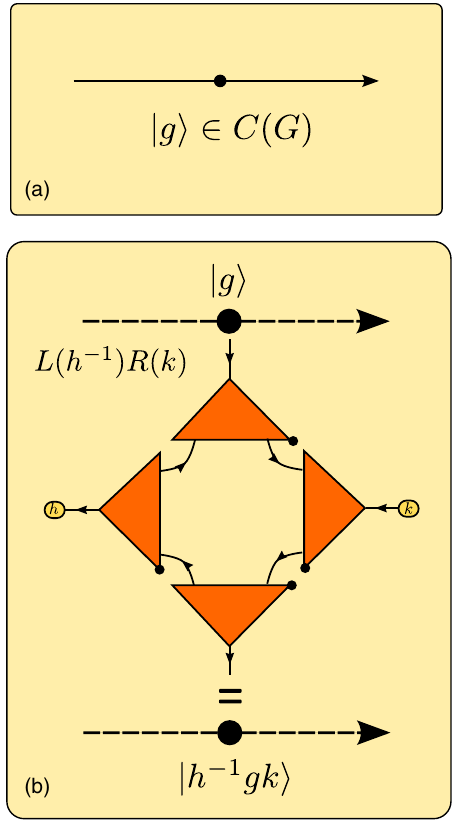
FIG. 6. Gauge boson constituents are defined on the links of an oriented lattice. Links are represented by dashed lines, and constituents are small solid circles along these lines (which should not be confused with tensors, whose legs are solids lines). (a) In the Kogut-Susskind LGT, each constituent is described by a state j g i of the group algebra C ð G Þ . (b) Left and right rotations L ð h − 1 Þ and R ð k Þ are introduced in Eqs. (11) and (12). They transform the state j g i into j h − 1 gk i . Both operators require an ⊗ ¯ V V initial change of basis from C ð G Þ to ⊕ , obtained r ð r r Þ through the W of Eq. (7) and represented in Fig. 4 (the first G horizontal triangle). One then applies to each of the legs the Γ h − 1 Þ ⊗ Γ k Þ(cid:2) , corresponding rotation matrix given by ⊕ r ½ r ð r ð with the individual Γ defined in Fig. 3(c) and represented here by r the two vertical triangles. At last, W † , represented by the inverted G triangle, allows us to go back to C ð G Þ